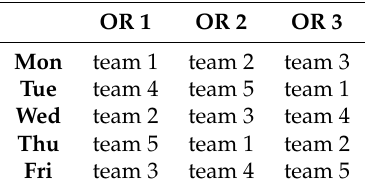
Table 5. OR time-table in the Orthopedic Surgical Department of the